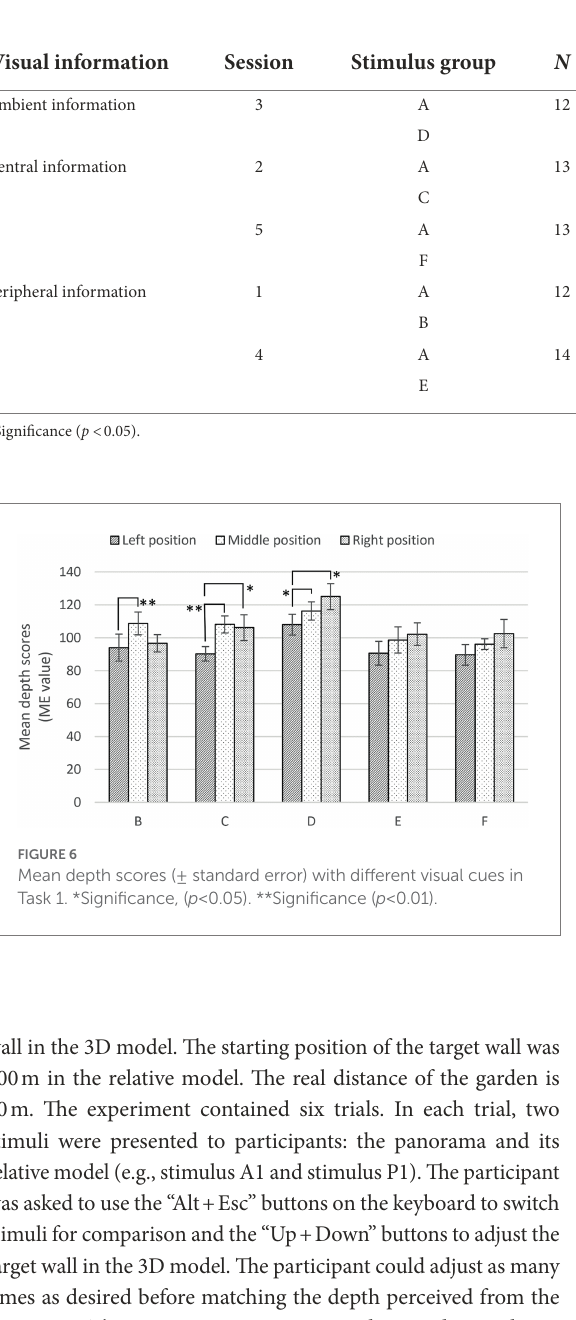
TABLE 4 Average depth scores among the three positions in each session in Task 1.